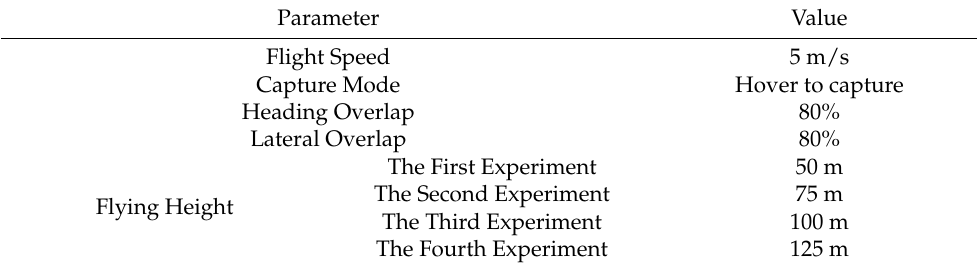
Table 2. UAV flight parameters.